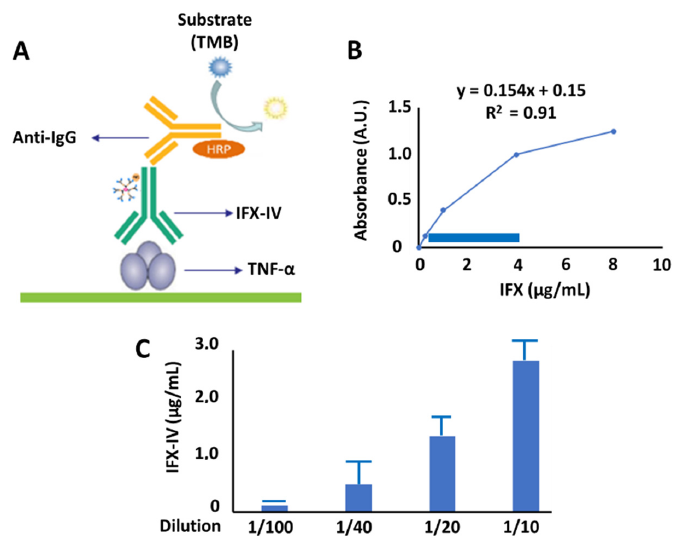
Figure 13. ( A ) ELISA experiment using TNF- α as a capture antigen. ( B ) Standard curve using IFX. ( C ) Compound IV-IFX concentration in a serial dilution.